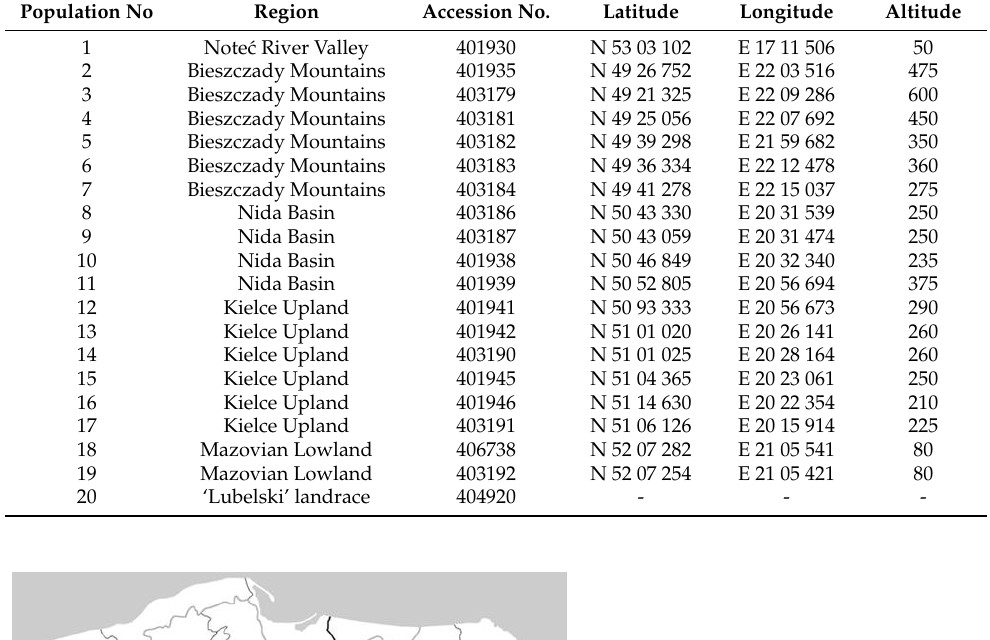
Table 4. Geographical coordinates of the common valerian populations.